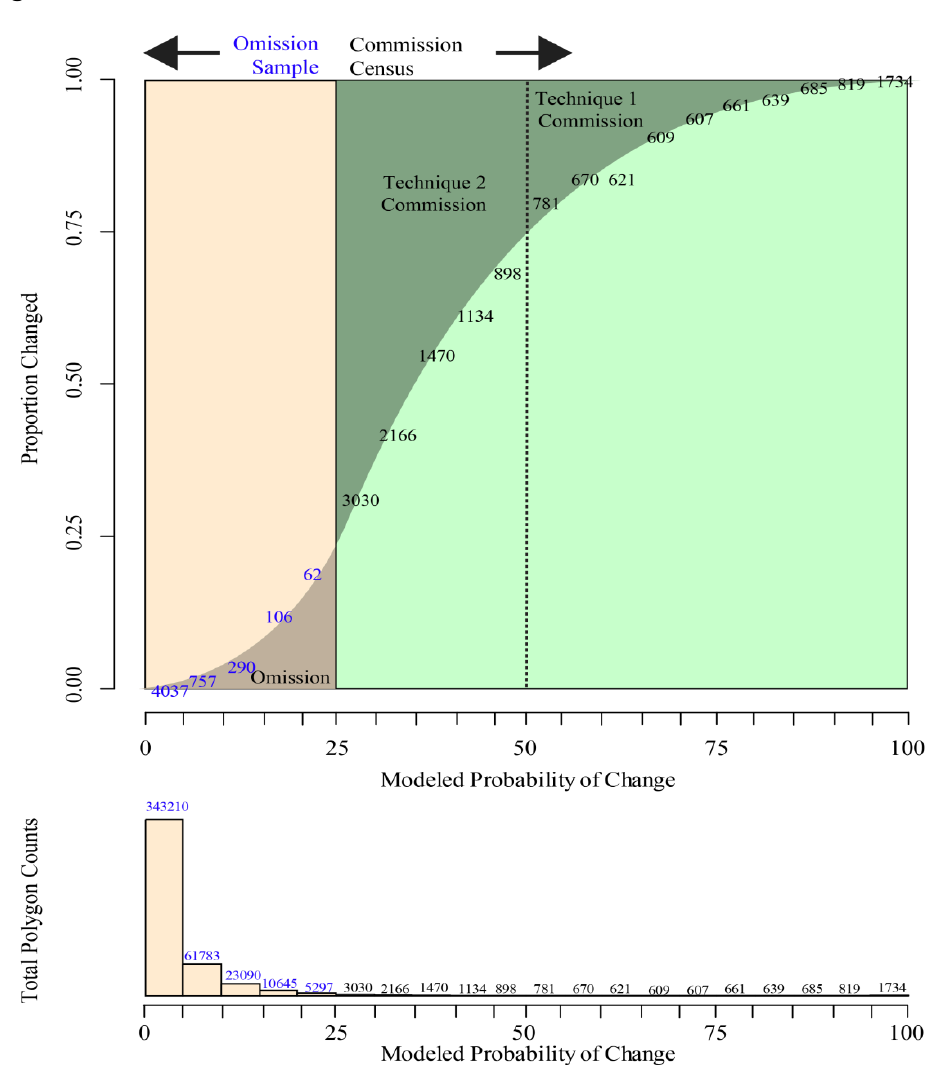
Figure 7. Plots of observed change proportion and polygon counts by 5% probability bins. The upper plot shows the number of observed polygons in each bin plotted on the y-axis as the percentage of observed change polygons for that bin. For example, the uppermost value of 1734 represents the 95%–100% probability bin for reviewed polygons which contained 1734 polygons of which all were actually change. Values to the right of 25% are complete censuses. Values to the left of 25% represent proportionate samples with change probabilities <25%. The darker areas represent errors of commission and omission. The light green area between 25 and 50% provides a graphical representation of additional change mapped from accuracy optimization technique 2, threshold lowering. The bottom histogram shows the total population of polygons in each